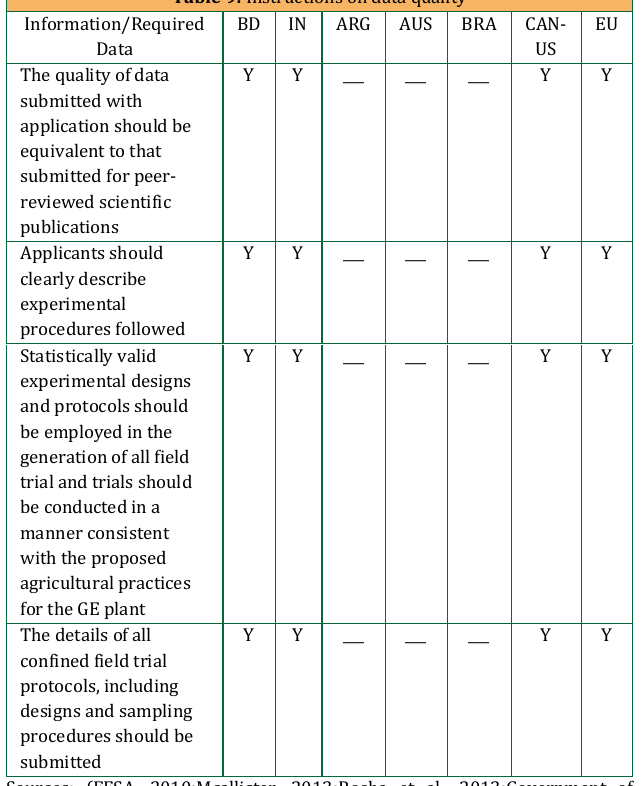
Table 9: Instructions on data